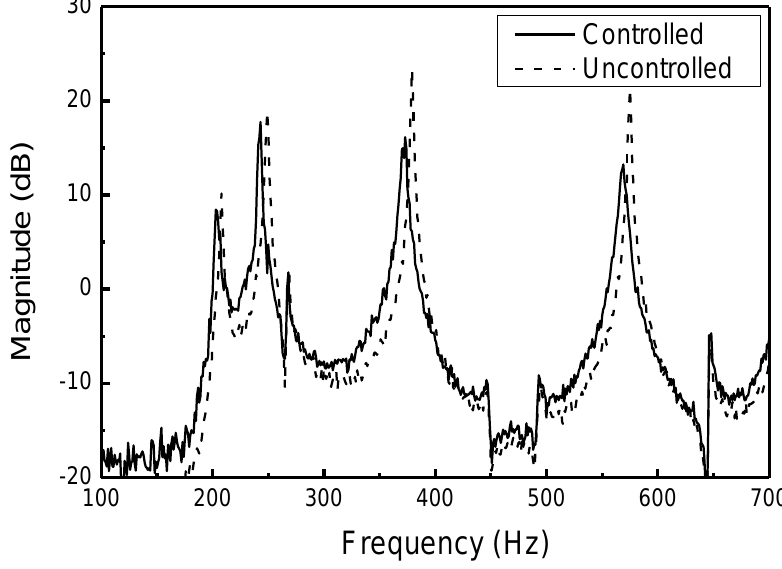
Figure 10. Frequency responses of the underwater cylindrical shell structure with and without active control.